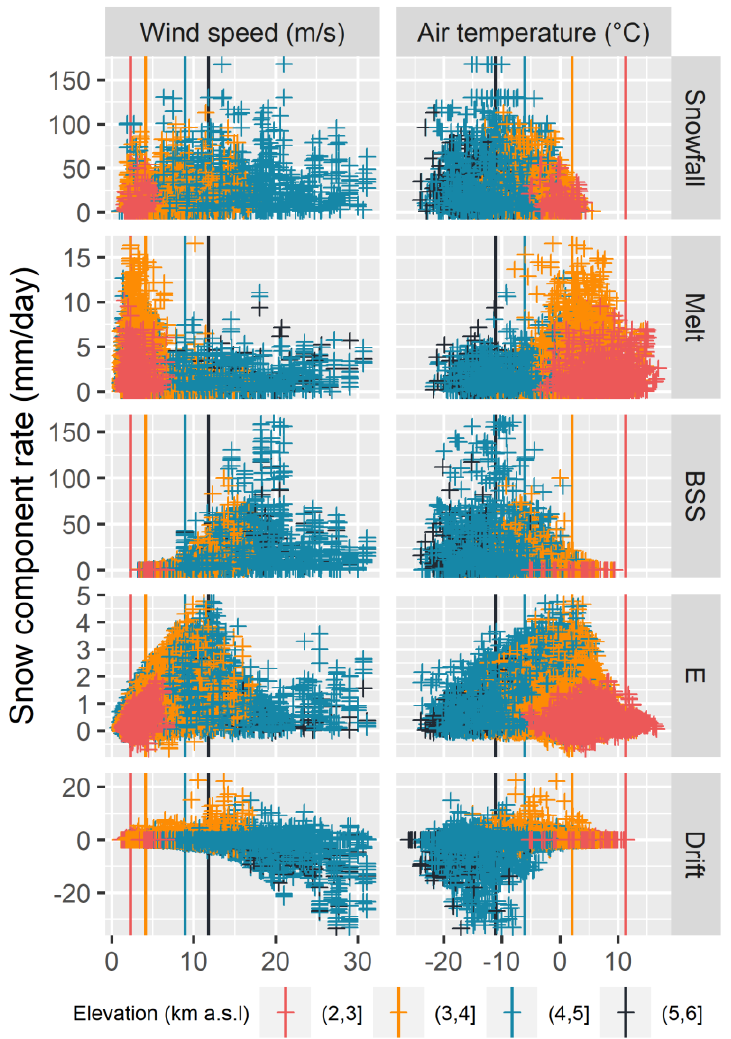
Figure 8. Daily rates of the snow components (mm/day) compared to the average wind speed and air temperature between 2001 and 2016. Colored by altitudinal bands of 1 km derived from the HRU in UCRB. BSS: blowing snow sublimation and E: surface sublimation. Vertical lines indicate the average May – December of wind speed and air temperature in each band.